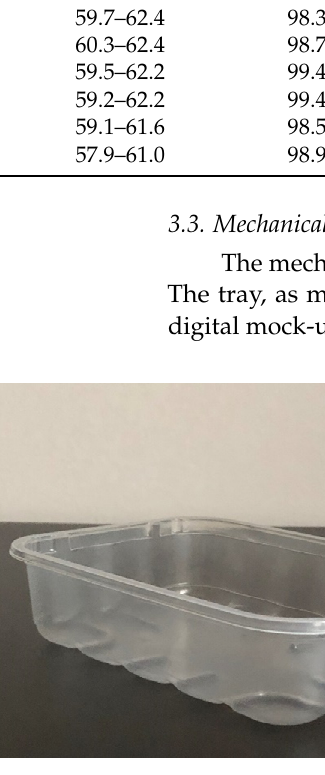
Figure 8. Original food tray and digital mock-up prepared from it.